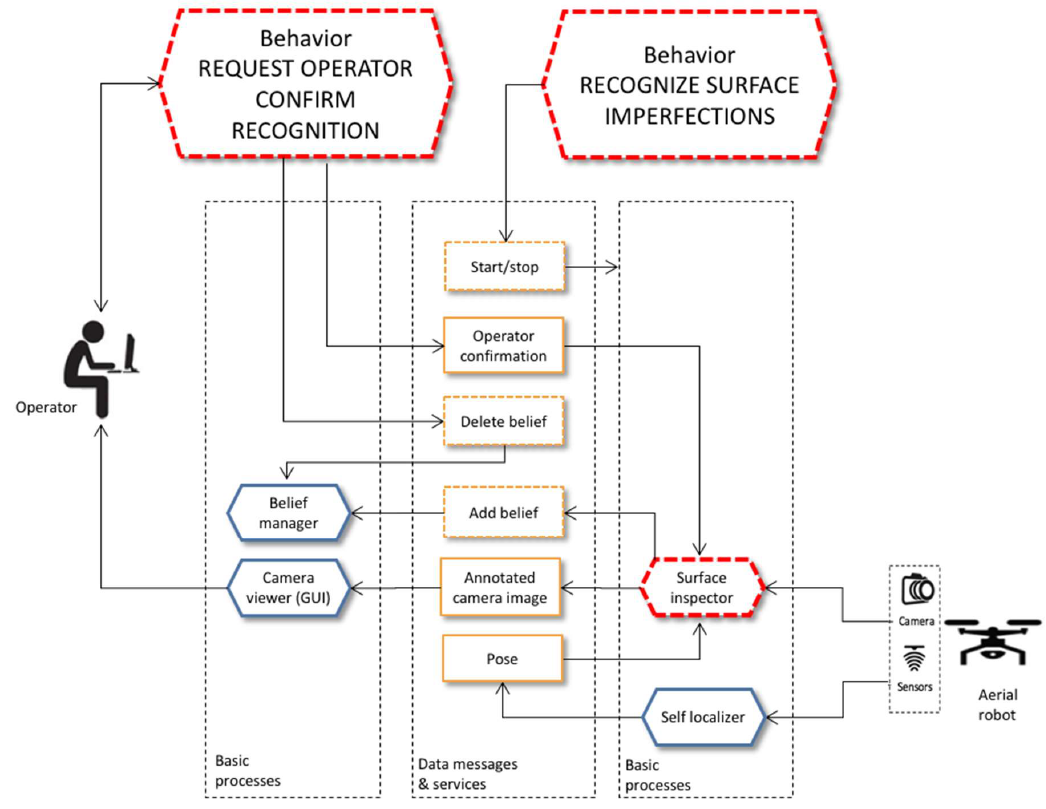
Figure 10. Example processes developed to support surface inspection (marked with a red dotted